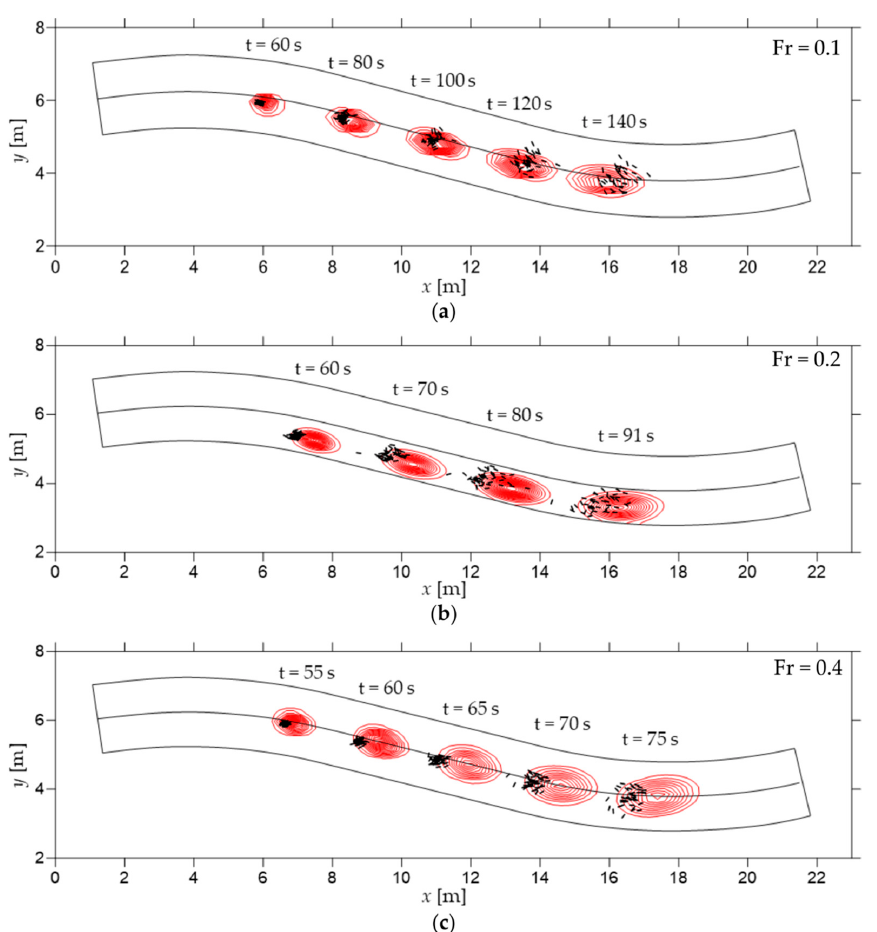
Figure 7. S-shaped channel, with experimental wood logs (black segments) and numerical volume averaged concentration (red contours) for different time instants. ( a ) Fr = 0.1, t R = 0.8 m, L w = 0.3 m, D w = 0.02 m. ( b ) Fr = 0.2, t R = 0.4 m, L w = 0.4 m, D w = 0.02 m. ( c ) Fr = 0.4, t R = 0.8 m, L w = 0.3 m, D w = 0.02